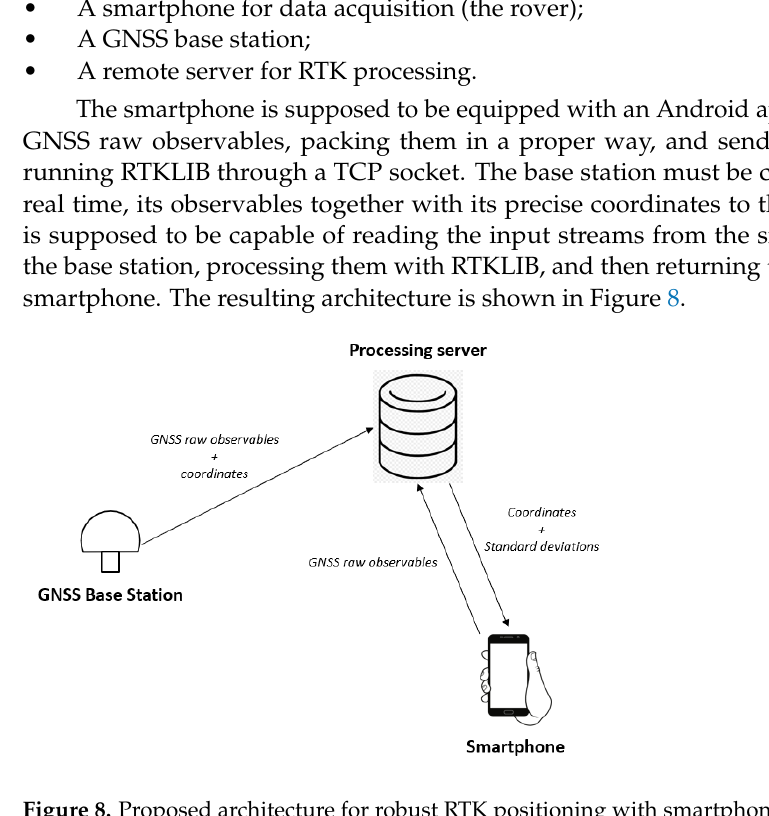
Figure 8. Proposed architecture for robust RTK positioning with